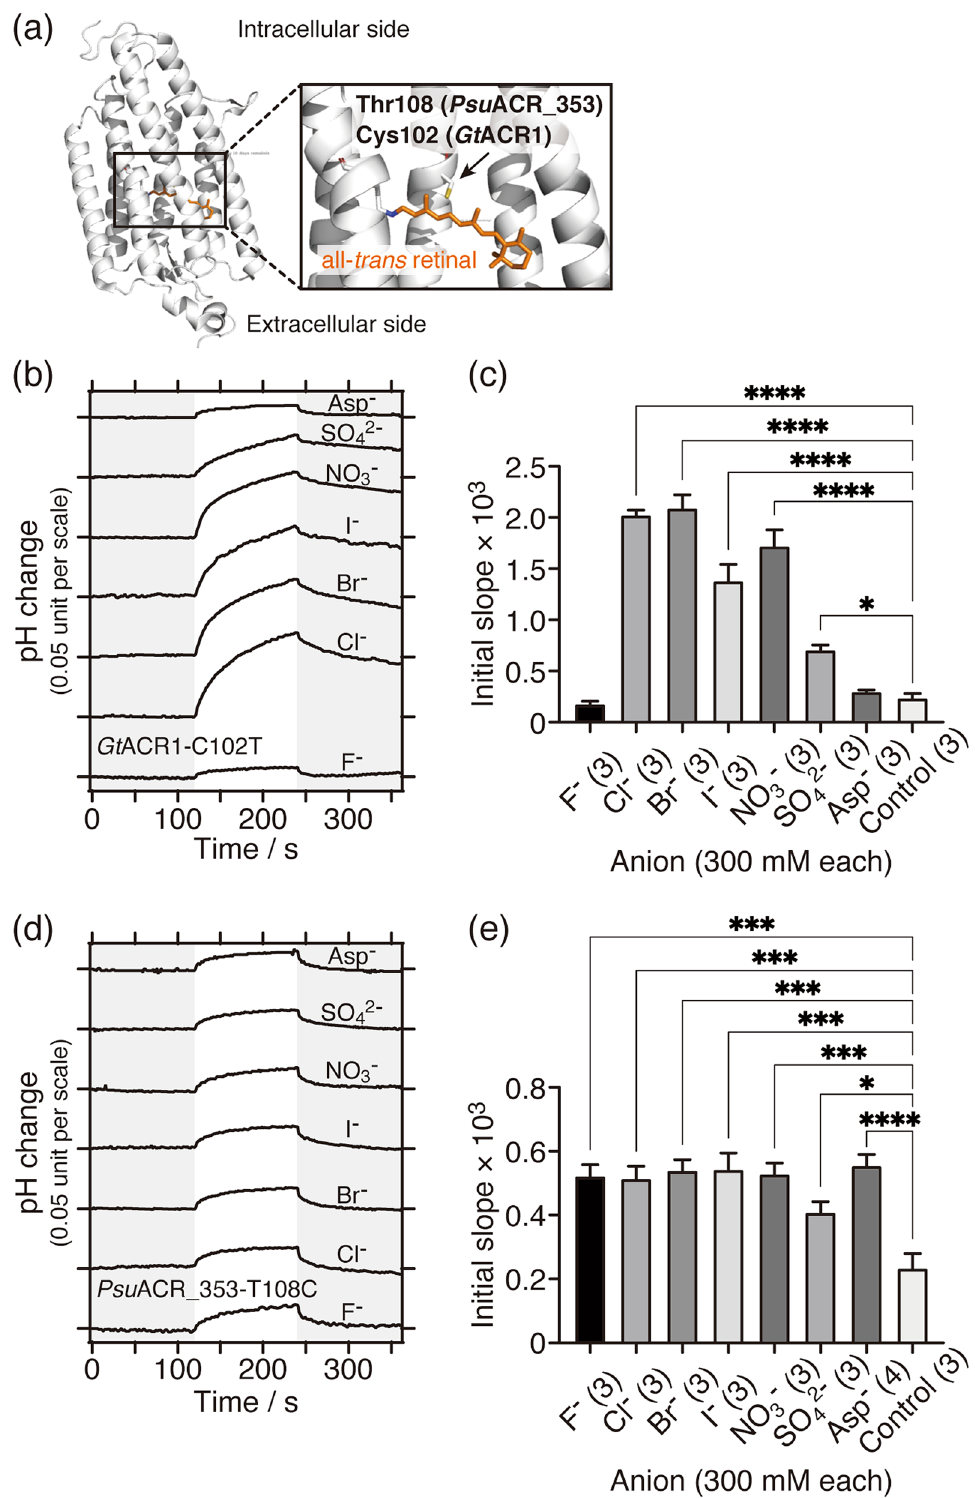
Figure 6. Anion transport activities of Gt ACR1-C102T and the Psu ACR_353-T108C mutants. ( a ) Location of the Cys102 residue in the Gt ACR1 structure (PDB ID 6CSM) 39 drawn by PyMOL software. Cys102 and the all- trans -retinylidene chromophore are shown in stick representation by PyMOL. ( b, d ) Comparisons of anion-dependent transport activities of ( b ) Gt ACR1-C102T and ( d ) Psu ACR_353-T108C mutants. 530 nm LED light (10 mW/cm 2 ) was illuminated for 2 min as shown on a white background. ( c, e ) Statistical comparisons of anion-dependent transport activities of ( c ) Gt ACR1-C102T and ( e ) Psu ACR_353-T108C mutants. Data are reported as means and S.E.M.; the numbers in parentheses indicate the number of independent experiments. One-way ANOVA followed by Dunnett’s test was performed ( p values; for Gt ACR1-C102T **** < 0.0001, * 0.0197; for Psu ACR_353-T108C **** < 0.0001, *** < 0.0007, * 0.0338). Negative controls are yeast cells without integration of any ACR gene resuspended in 300 mM